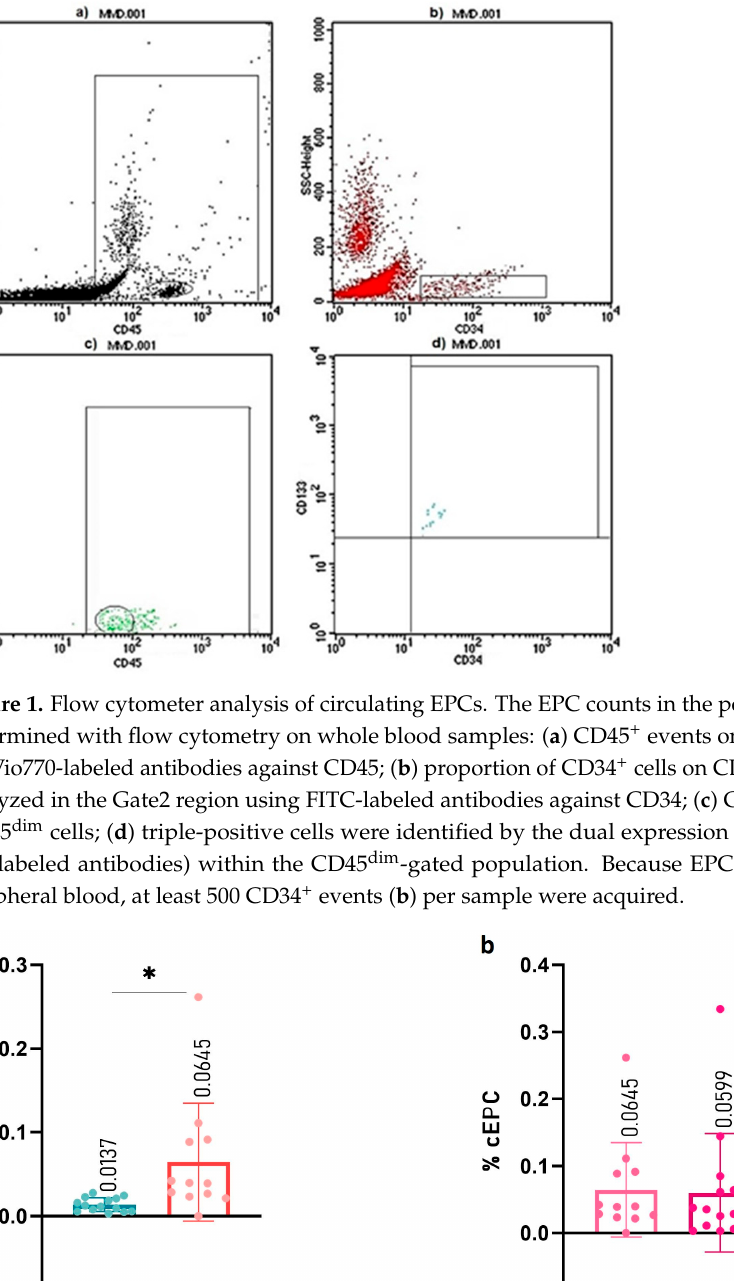
Figure 2. Circulating endothelial progenitor cell (cEPC) in whole blood. ( a ) cEPC levels from a preoperatory set of MMA patients (n = 12) as compared with unrelated controls (UNR, n = 14). ( b ) cEPC levels from a homogeneous group of MMA patients before (pre OP, n = 12) and after (post OP, n = 14) the neurosurgical procedures. Data are expressed as the mean of cEPC% ± SD, where the cEPC% value was calculated as follows: (cEPCs/µL/White Blood Cells/µL) × 100. Error bars